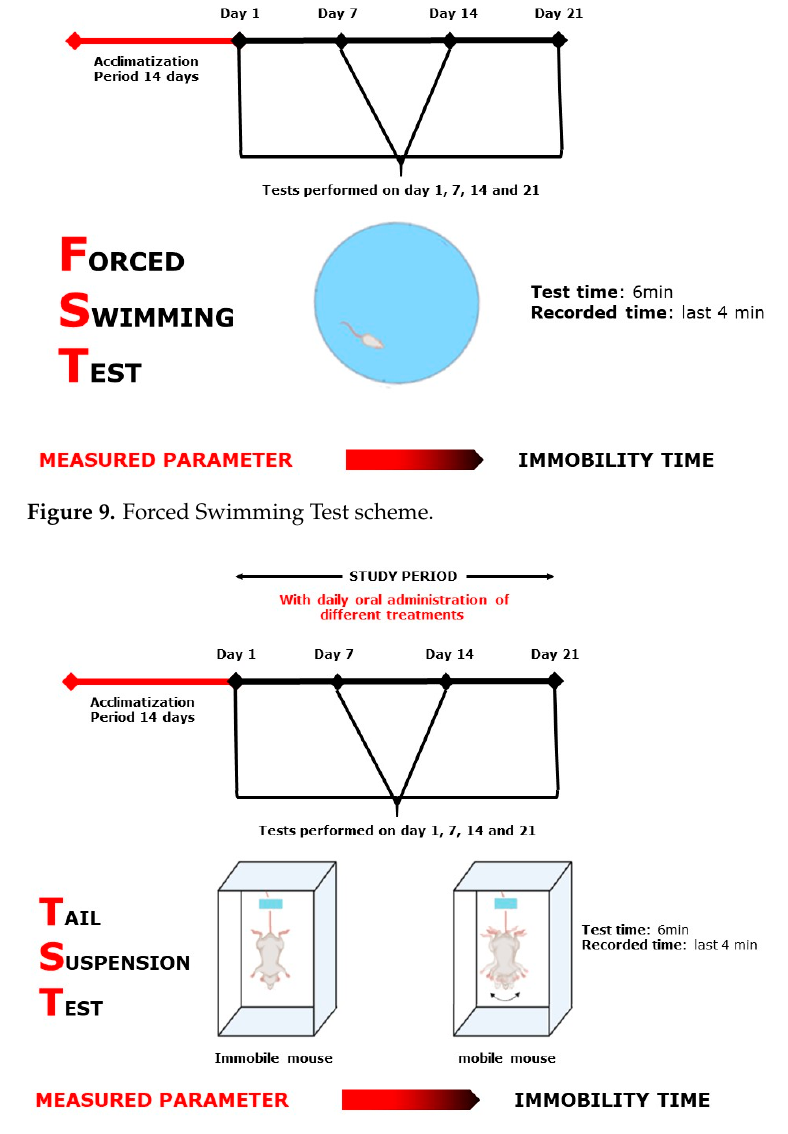
Figure 10. Tail Suspension Test scheme.